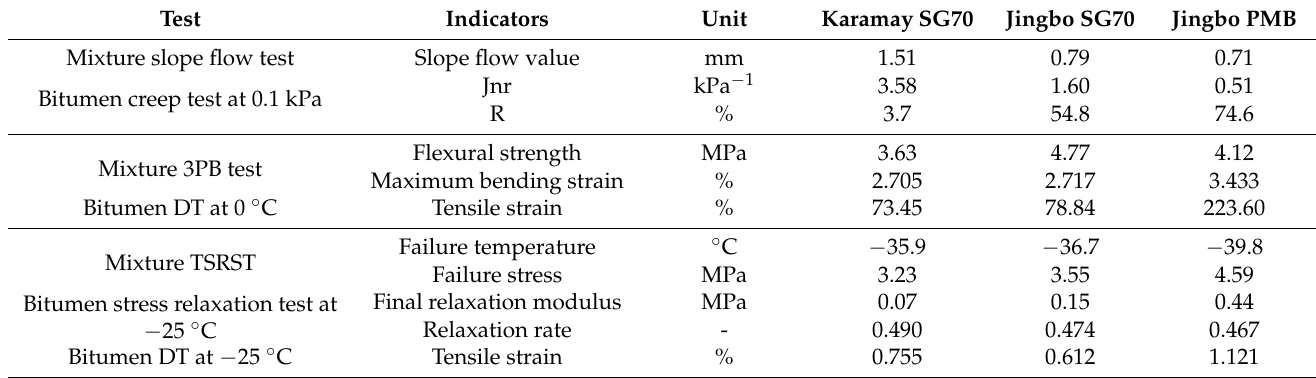
Table 9. Test results of hydraulic asphalt mixture and the relation with bitumen